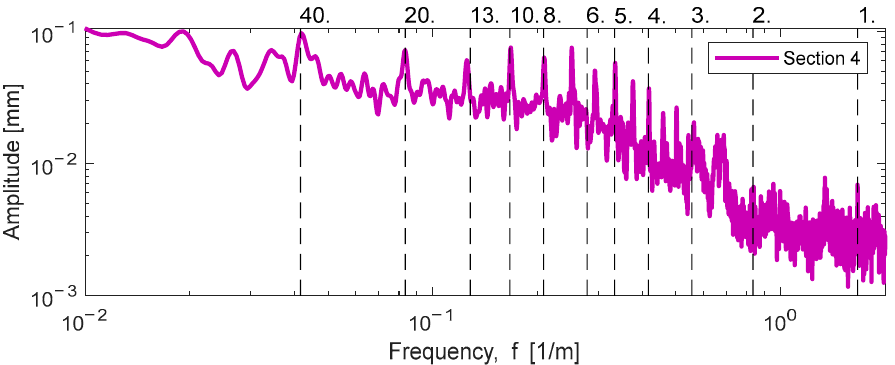
Figure 9. FAS of TG with the indication of harmonic oscillation modes of sleeper spacing distance. Table 7. Discrete Wavelengths associated with Outliers in FAS of TG in Section 4 (see Figure 9). The Characteristic Discrete Wavelength of the Track Gauge (In Track Section 4)